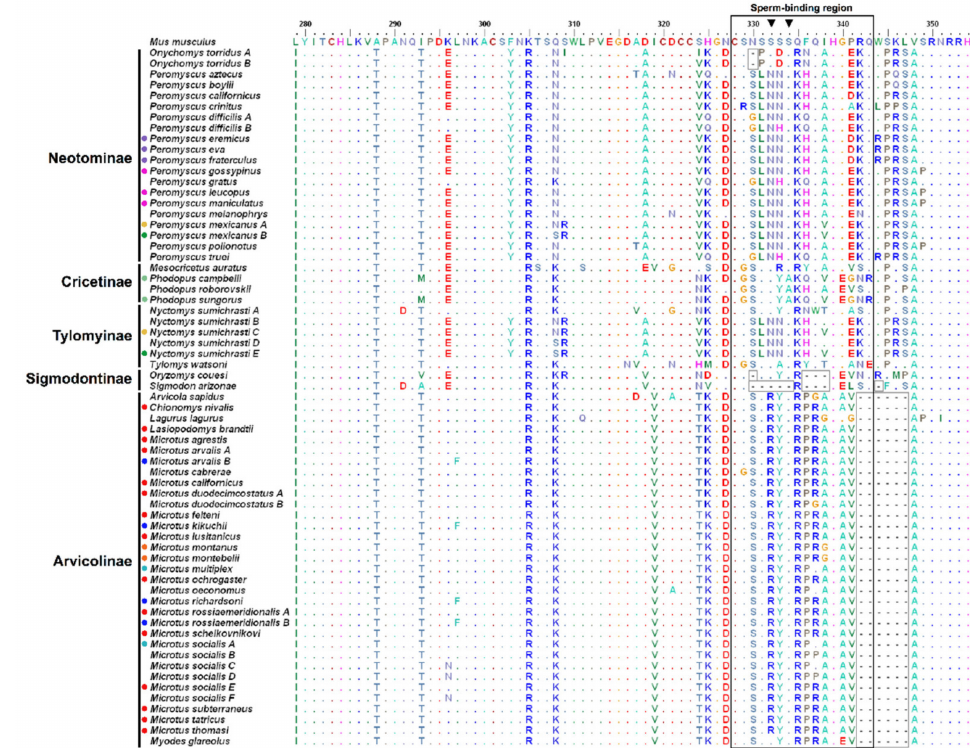
Figure 2. ZP3 exons 6 and 7 amino acid sequence alignment of Cricetidae from the five extant subfamilies. Dots represent amino acids identical to the reference Mus musculus sequence and colored circles before species names denote shared haplotypes. The black outlined rectangle delimits the putative sperm-binding region according to [15]. Grey outlined squares highlight deletions relative to M. musculus . Black inverted triangles indicate glycosylation sites S-332 and